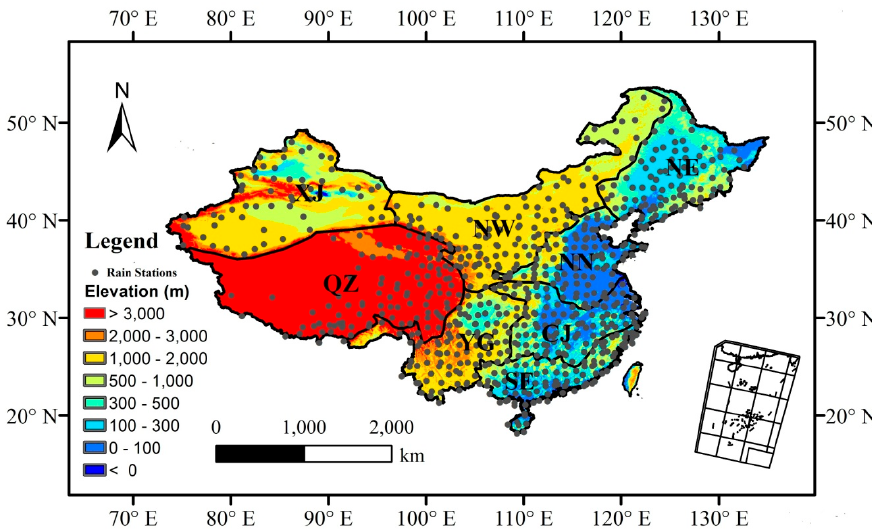
Figure 1. Study area, the spatial distribution of meteorological stations, and the eight sub-regions: the Xinjiang region (XJ), the Qinghai-Tibetan Plateau (QZ), Northwestern China (NW), Northeastern China (NE), Northern China (NN), the southwest Yungui Plateau (YG), the plain region of Changjiang (Yangtze) River (CJ), and Southeastern China (SE).